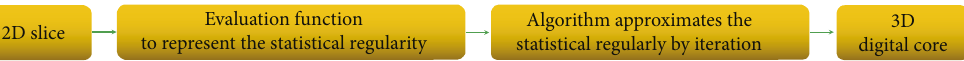
Figure 15: Abstraction of the stochastic reconstruction method based on 2D slice statistical constraint features. The e ff ect of 2D slice to 3D digital core is determined by the evaluation function and algorithm. The evaluation function is one of the important parameters that determine the e ff ect of 3D digital core